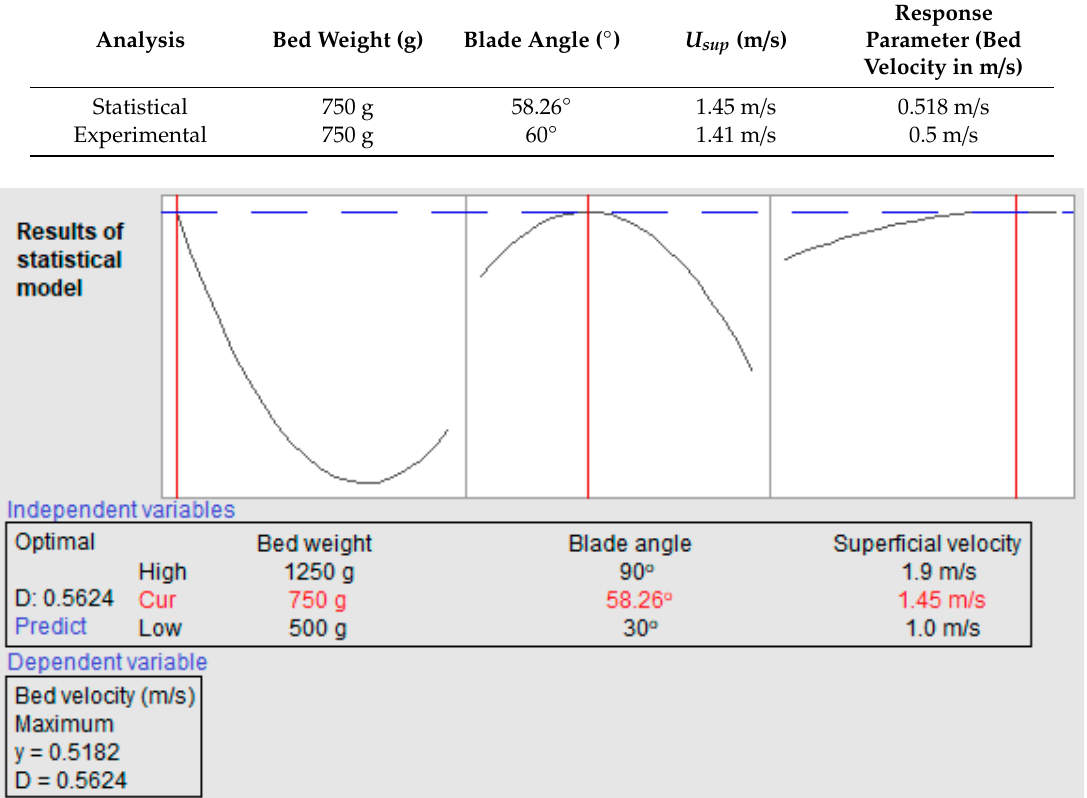
Table 3. Comparison of statistical findings of bed weight, blade angle and superficial velocity with experimental findings for 4 mm particles.